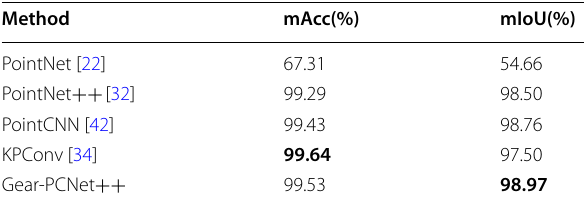
Table 4 Segmentation results of gear data set Table 5 Recognition accuracy of points in each